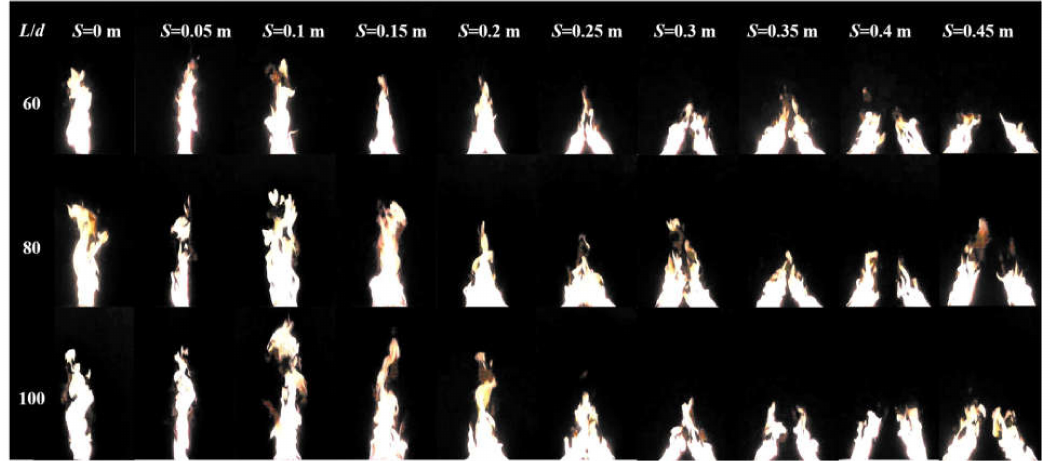
Figure 7. Typical snapshots of combustion behavior of two parallel line